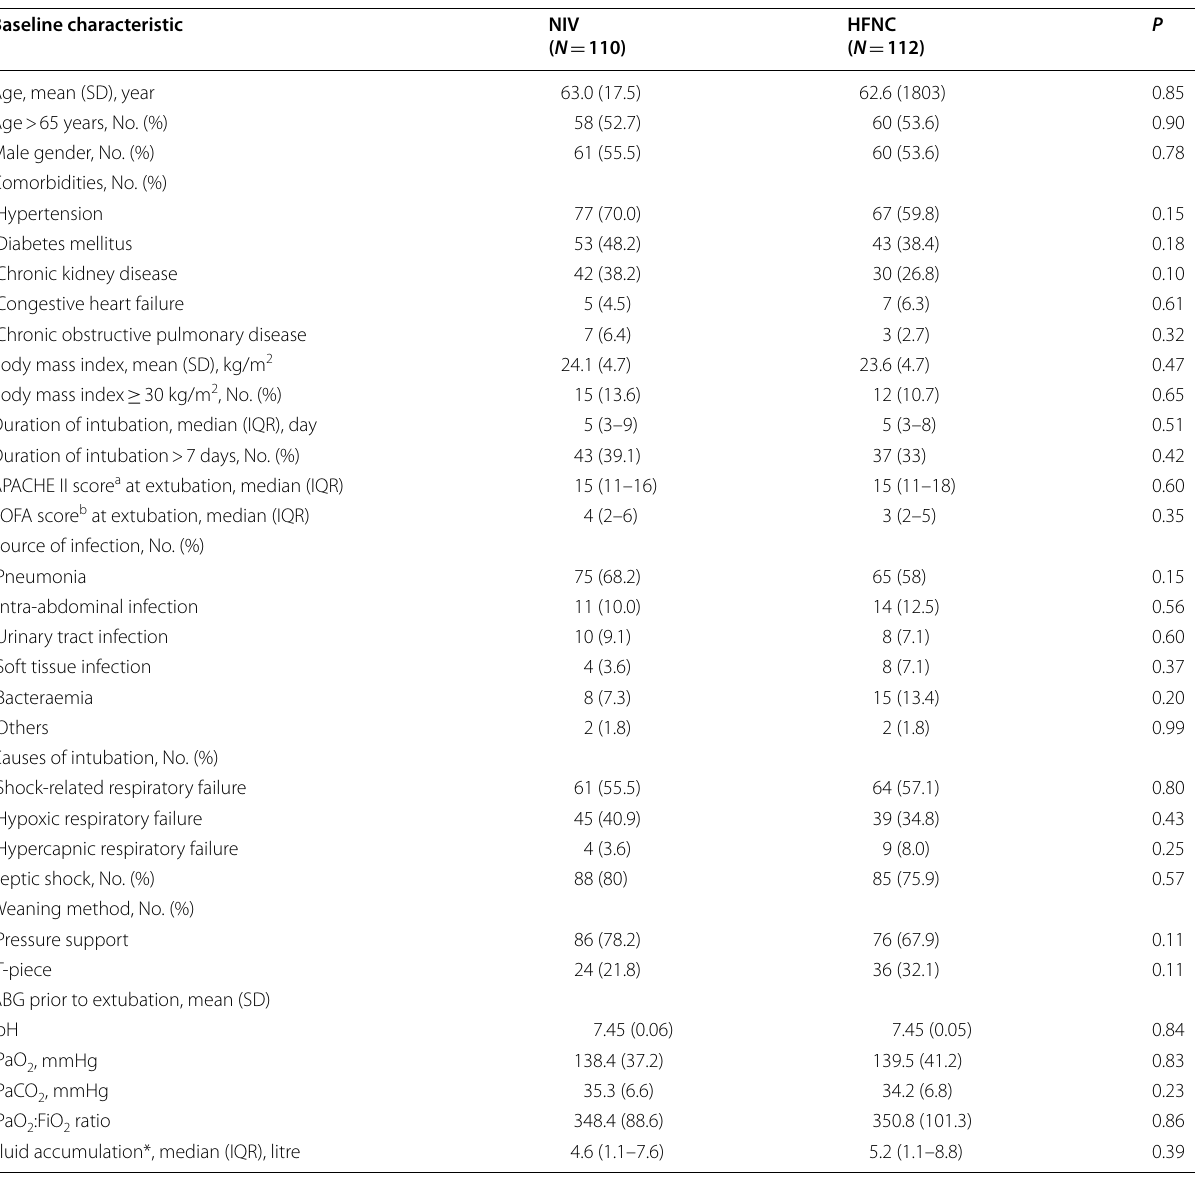
Table 1 Baseline characteristics of the